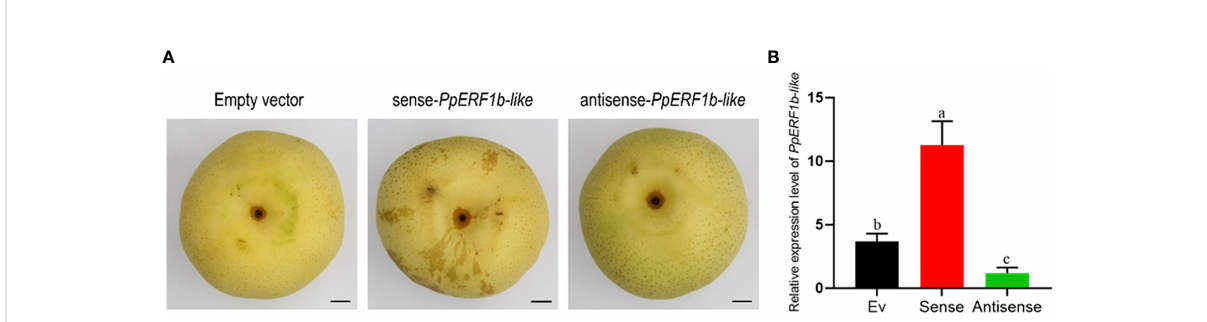
FIGURE 4 The relative expression level of PpERF1b-like in transient overexpression fruit. (A) Phenotype of transient overexpression of fruit. Scale bars = 100 m m. (B) The relative expression level of PpERF1b-like in pear fruit surrounding the site of in fi ltration. Data are given as mean ± SD (n = 4). a-c, the different letters indicate signi fi cant differences between groups ( p < 0.05; Duncan ’ s multiple-range test). Ev: Empty vector, Sense: Sense- PpERF1b-like , Antisense: Antisense- PpERF1b-like